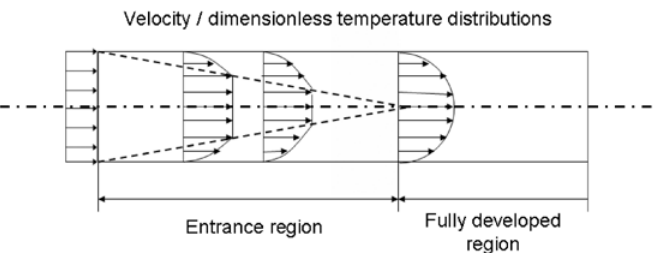
Fig. 9 Boundary layer development in a pipe flow in the laminar flow regime; for turbulent flow, the entrance region is much shorter and the boundary layer thickness is